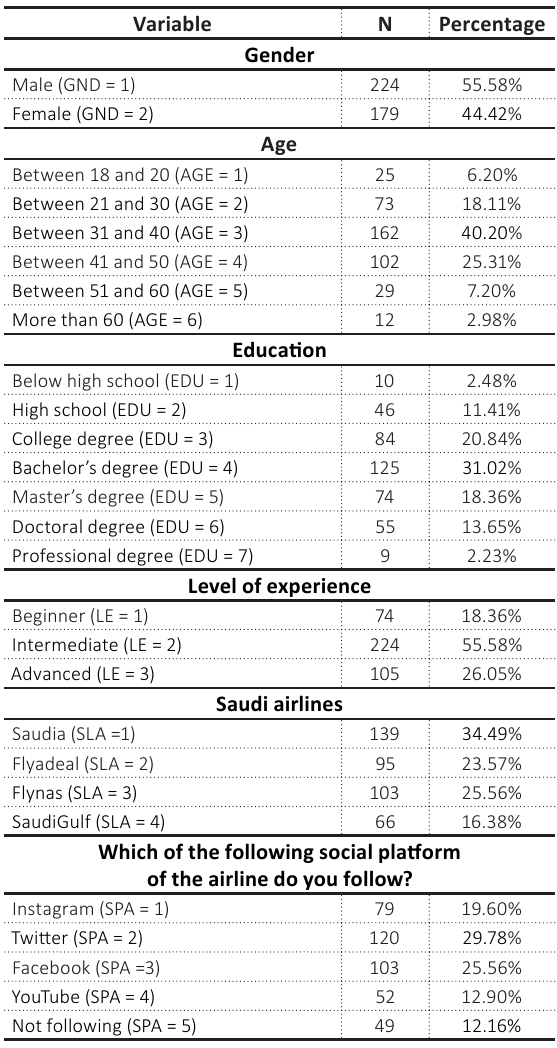
Table 1. Demographic information of